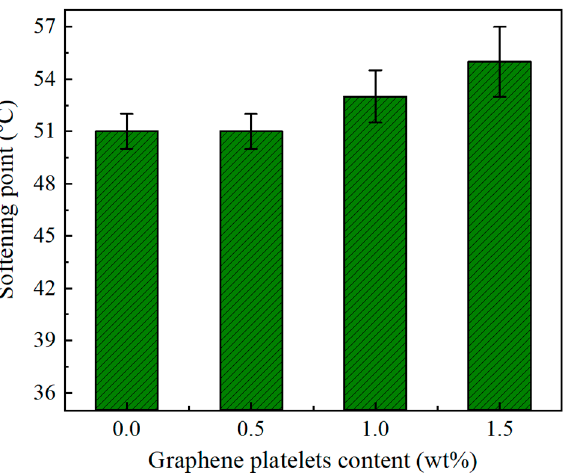
Figure 7. Softening point of unmodified asphalt and its graphene platelets nanocomposites.